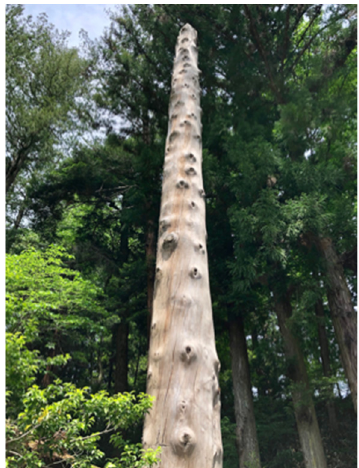
Figure 6. The sacred pillar called as “ Harumiya ichi no Onbashira ”, the thickest of the four pillars built in the Shimosha Harumiya (Lower Shrine Harumiya) of Suwa Taisha in 2016. Four Suwa Taisha (Suwa Grand Shrines) are located in Suwa. They are the headquar- ters of all of Japan’s Suwa shrines, located around Lake Suwa, with Maemiya and Honmiya being located in the Kamisuwa region and Akimiya and Harumiya being lo- cated in the Shimosuwa region. The Onbashira festival is held at each of these shrines once